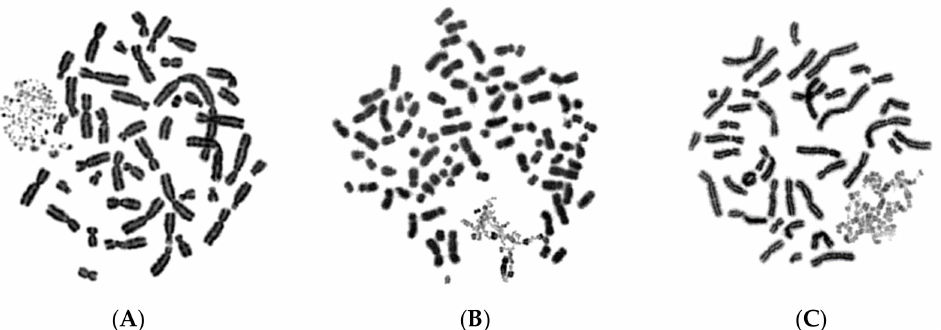
Figure 1. Early-S, mid-S and late-S MN PCCs. In micronucleated cells generated by exposure of G 0 -lymphocytes to ionizing radiation (IR) (4 Gy), chromosome shattering of chromosomal material entrapped in micronuclei (MN) can occur through premature chromosome condensation (PCC), if MN are in S phase when main nuclei enter mitosis. Upon entry of main nuclei into mitosis, the nuclear envelope of MN disassembles and, through the mitotic cyclin B1-CDK1 activity and histone phosphorylation, the shattering and morphology of prematurely condensed chromosomes (PCCs) characterizes the stage in S phase of MN. Based on the degree of completion of DNA replication, the MN PCCs can be classified as: ( A ) early-S, ( B ) mid-S, and ( C ) late-S phase. Darkly stained metaphasic chromosomes belong to main nuclei, while lightly stained shattered chromosomal material indicate anaphase lagging chromosomes entrapped in MN.